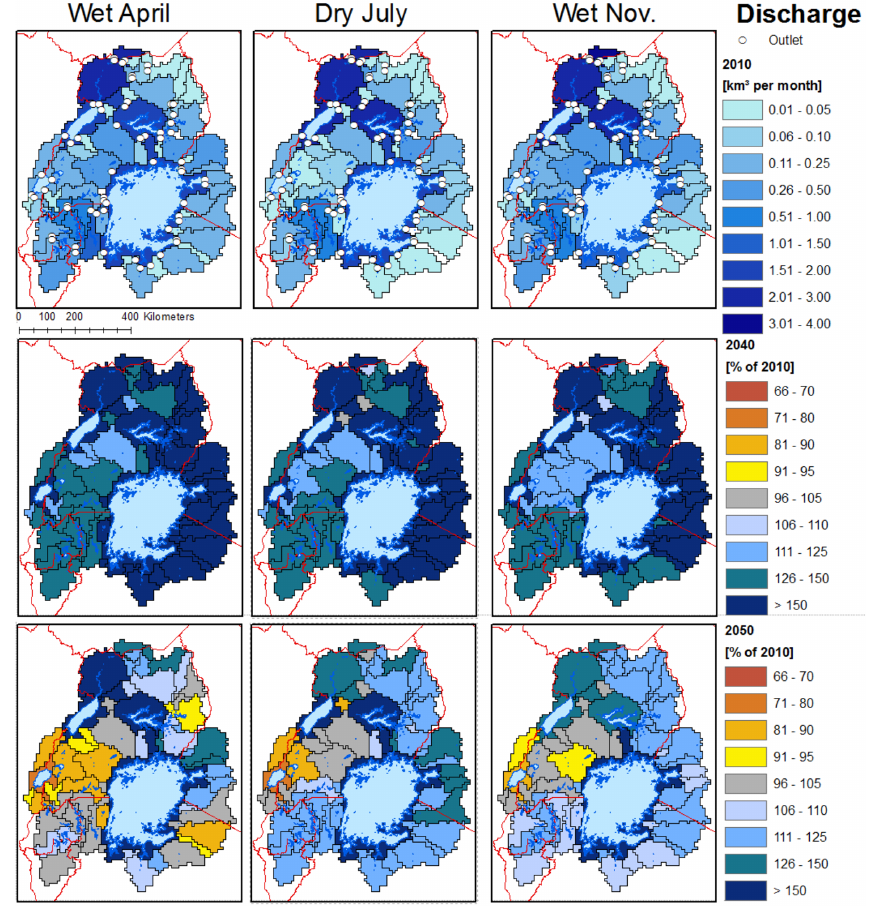
Figure 7. Change of seasonal discharge pattern from 2010 to 2040 and for 2050. Table 9. Water Crowding Index and Water Exploitation